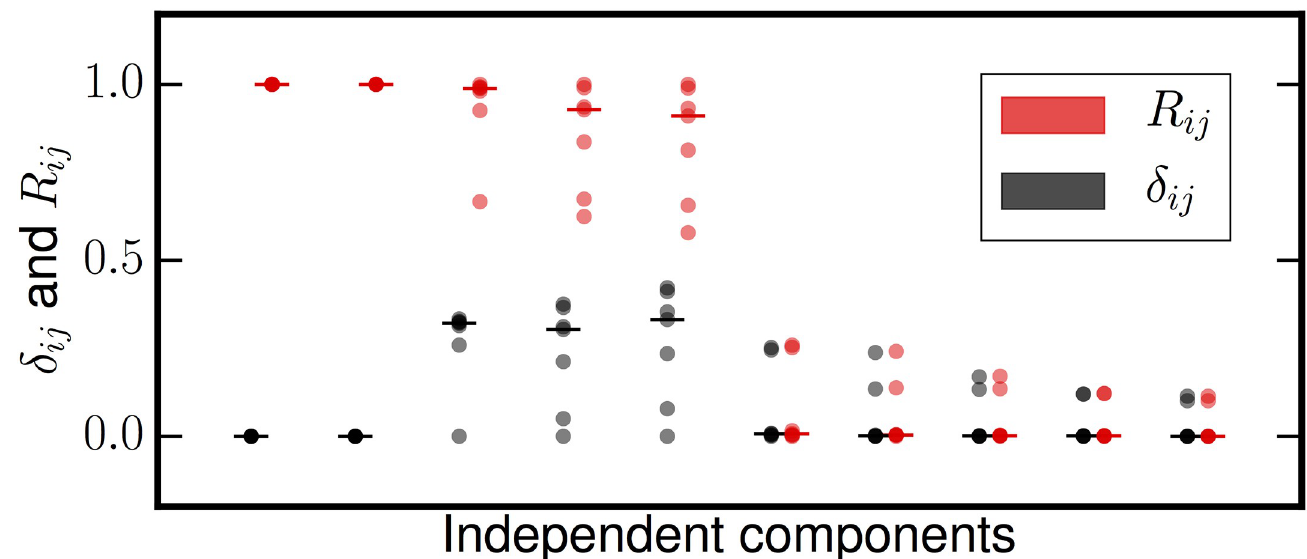
Fig 4. Reproducibility ( R ) and reproducibility fluctuations ( δ ij ) from overextraction. Only five sources (Gaussian or otherwise)are present, but the mixture dimensionis ten. Horizontalbars are locatedat the medianvalue. There are clearly three groups of sources here. Two sources (the recoveredsparse sources) have near-perfect R that does not fluctuate from decimation-to-decimation. Three sources have occasionally high reproducibility, but also significant δ ij ; these are the Gaussian subspace. The remaining five sources have very low reproducibility that fluctuatesvery little; these sources are spurious sources resultingfrom